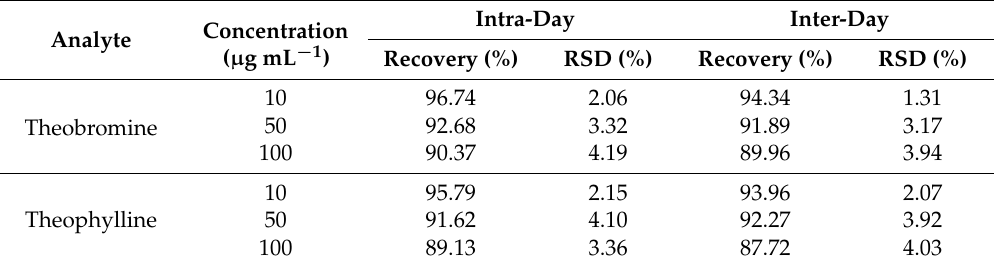
Table 2. Intra-day and Inter-day precisions and accuracies of theobromine and theophylline. Analyte